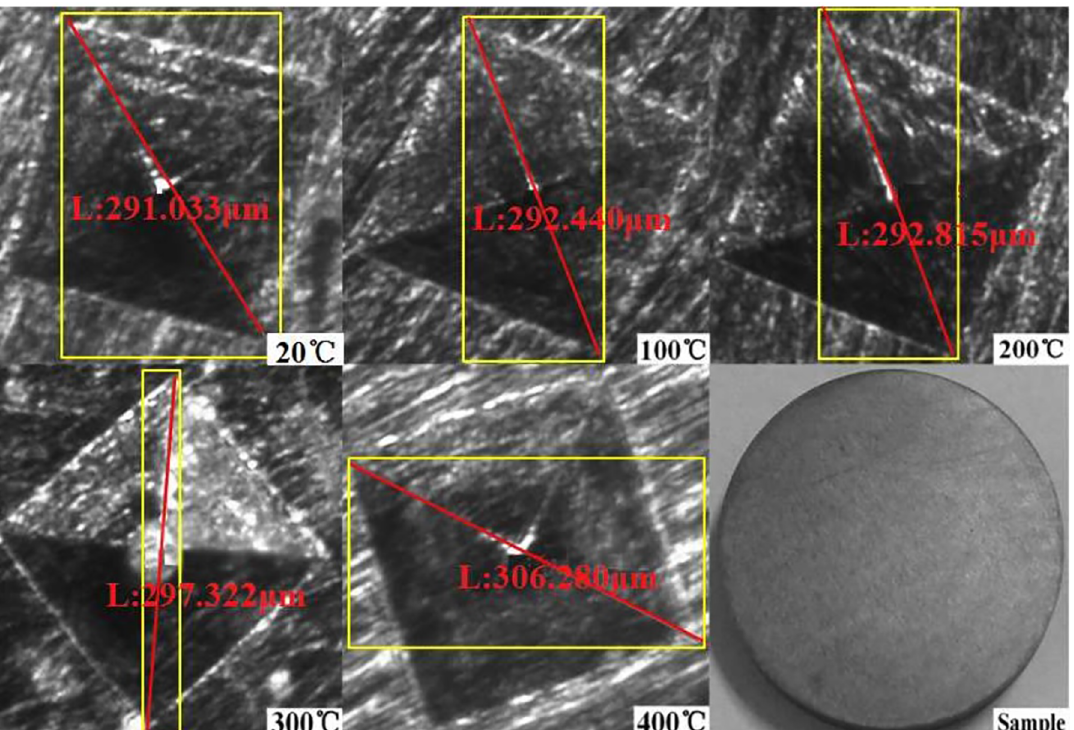
Figure 4. The sample indentations under different temperatures. Note: the red diagonals are the diagonal length of mean indentation ( d